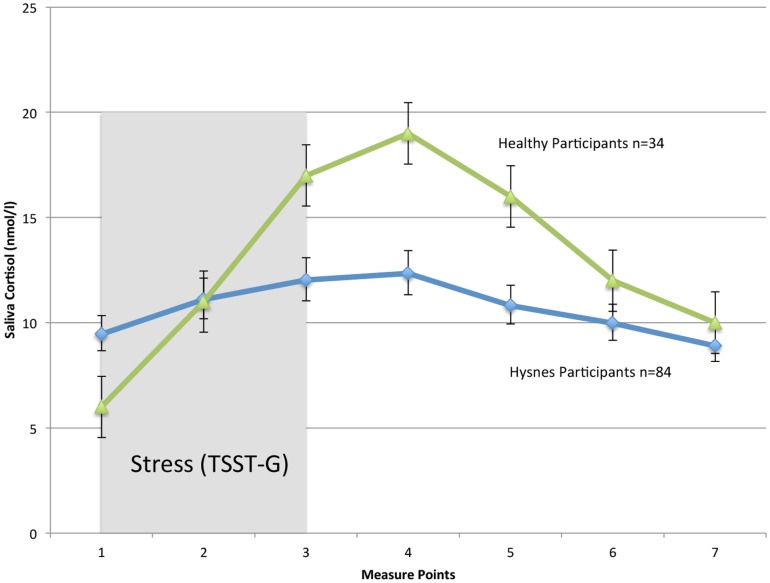
Cortisol responses to a standardized psychosocial stress test (TSST-G) in participants on long-term sick leave attending Hysnes Rehabilitation Center (n = 84) and healthy subjects (n = 34) adapted from von Dawans et al [24] (licensed reuse by Elsevier, license number: 3175410277640) exposed to identical experimental procedures (TSST-G).The gray bar represents the TSST-G exposure phase, and error bars represent 95% confidence intervals.